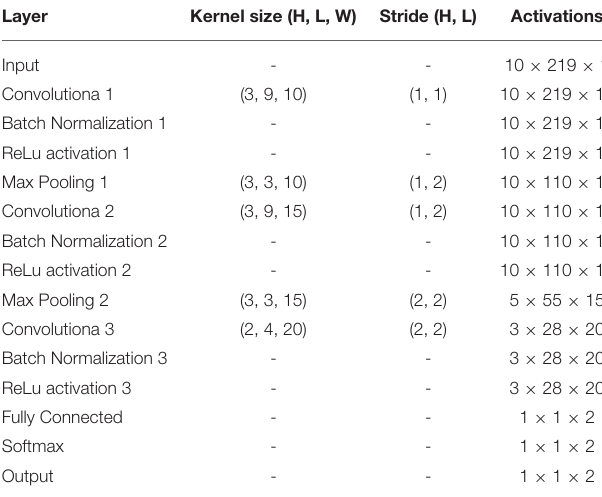
TABLE 2 | Properties of the